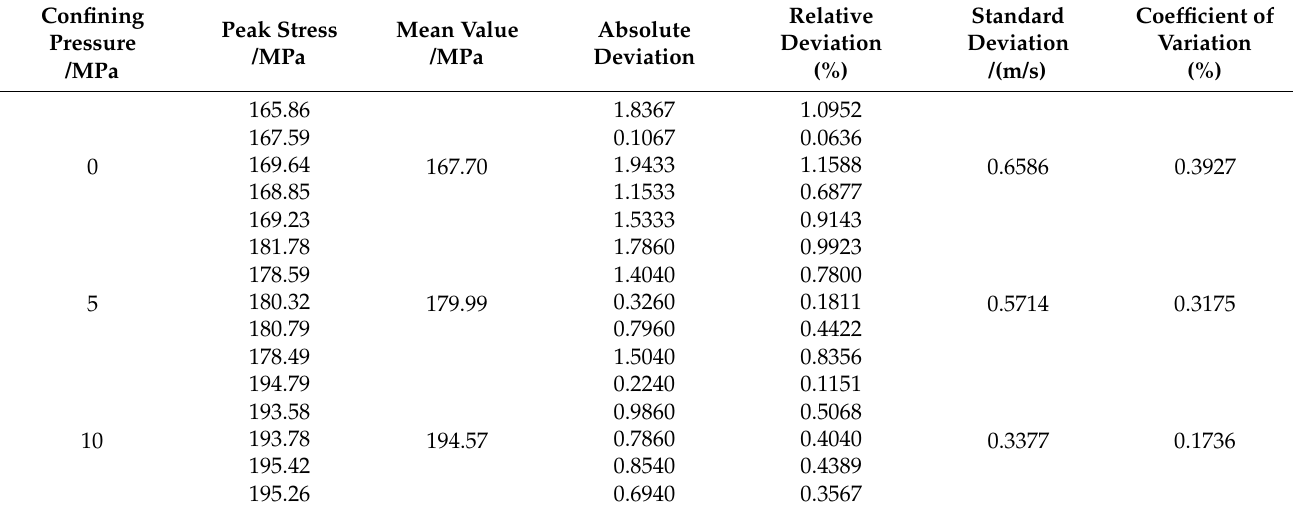
Figure 5. Typical stress–strain curve of shale samples in CTC tests. Table 3. Statistical analysis results of peak stress in CTC tests.